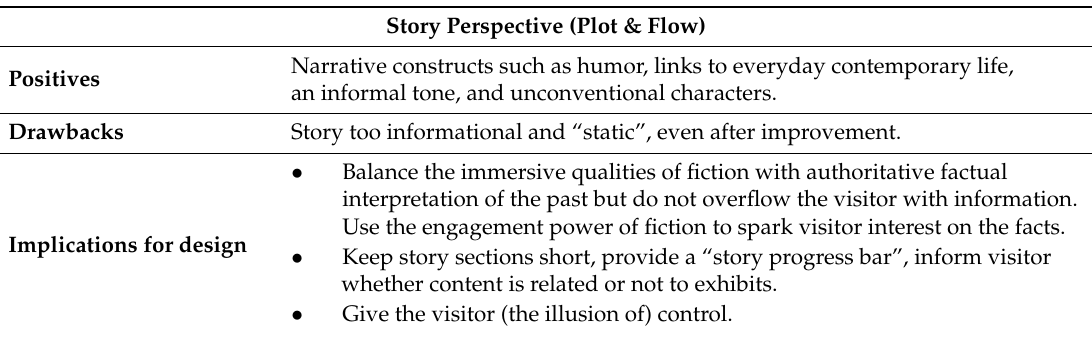
Table 3. Insights (pros, cons) from findings on the story perspective, and implications for